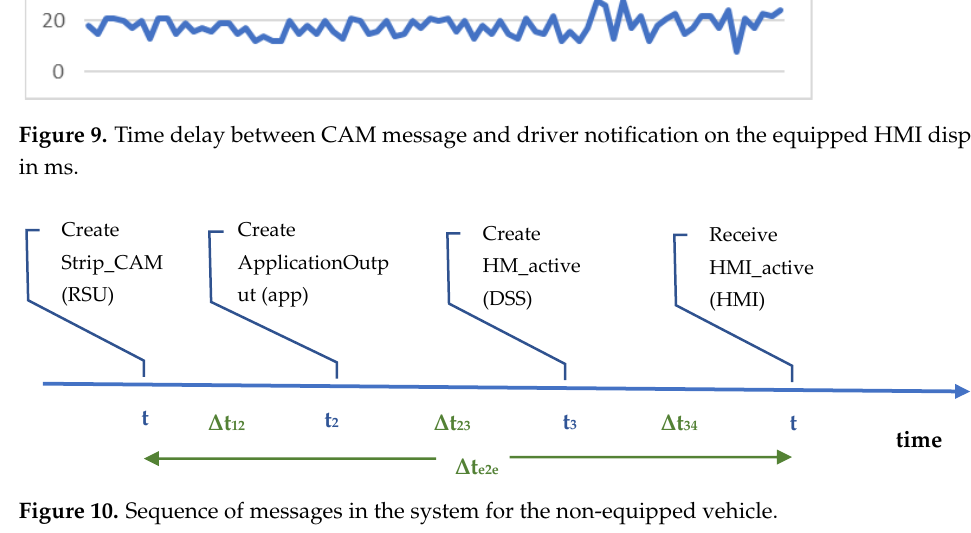
Figure 10. Sequence of messages in the system for the non-equipped vehicle.